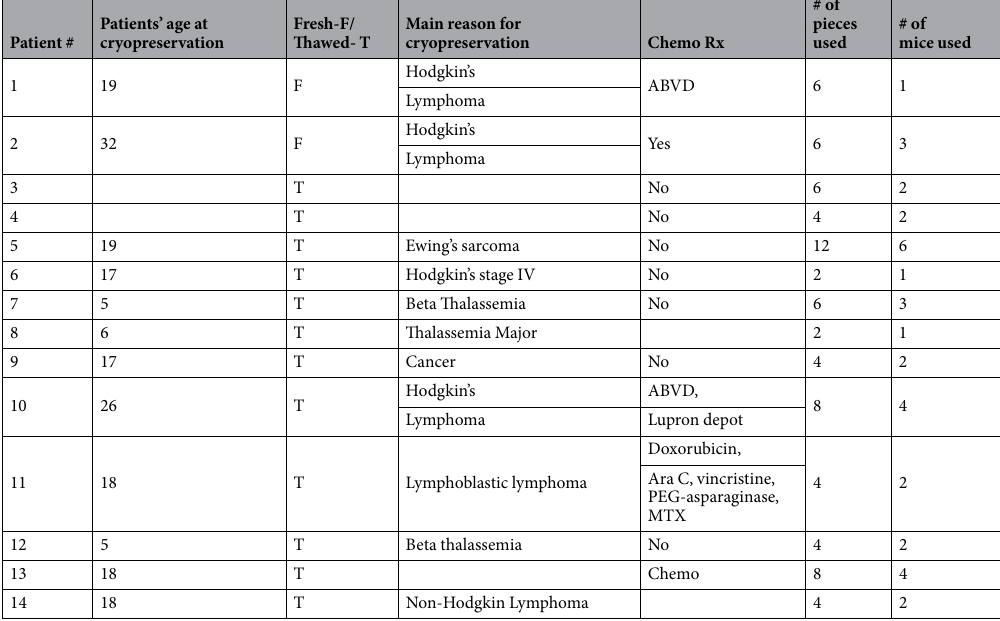
Table 1. List of patient characteristics for ovarian tissue fragments that were xenografted into NSG